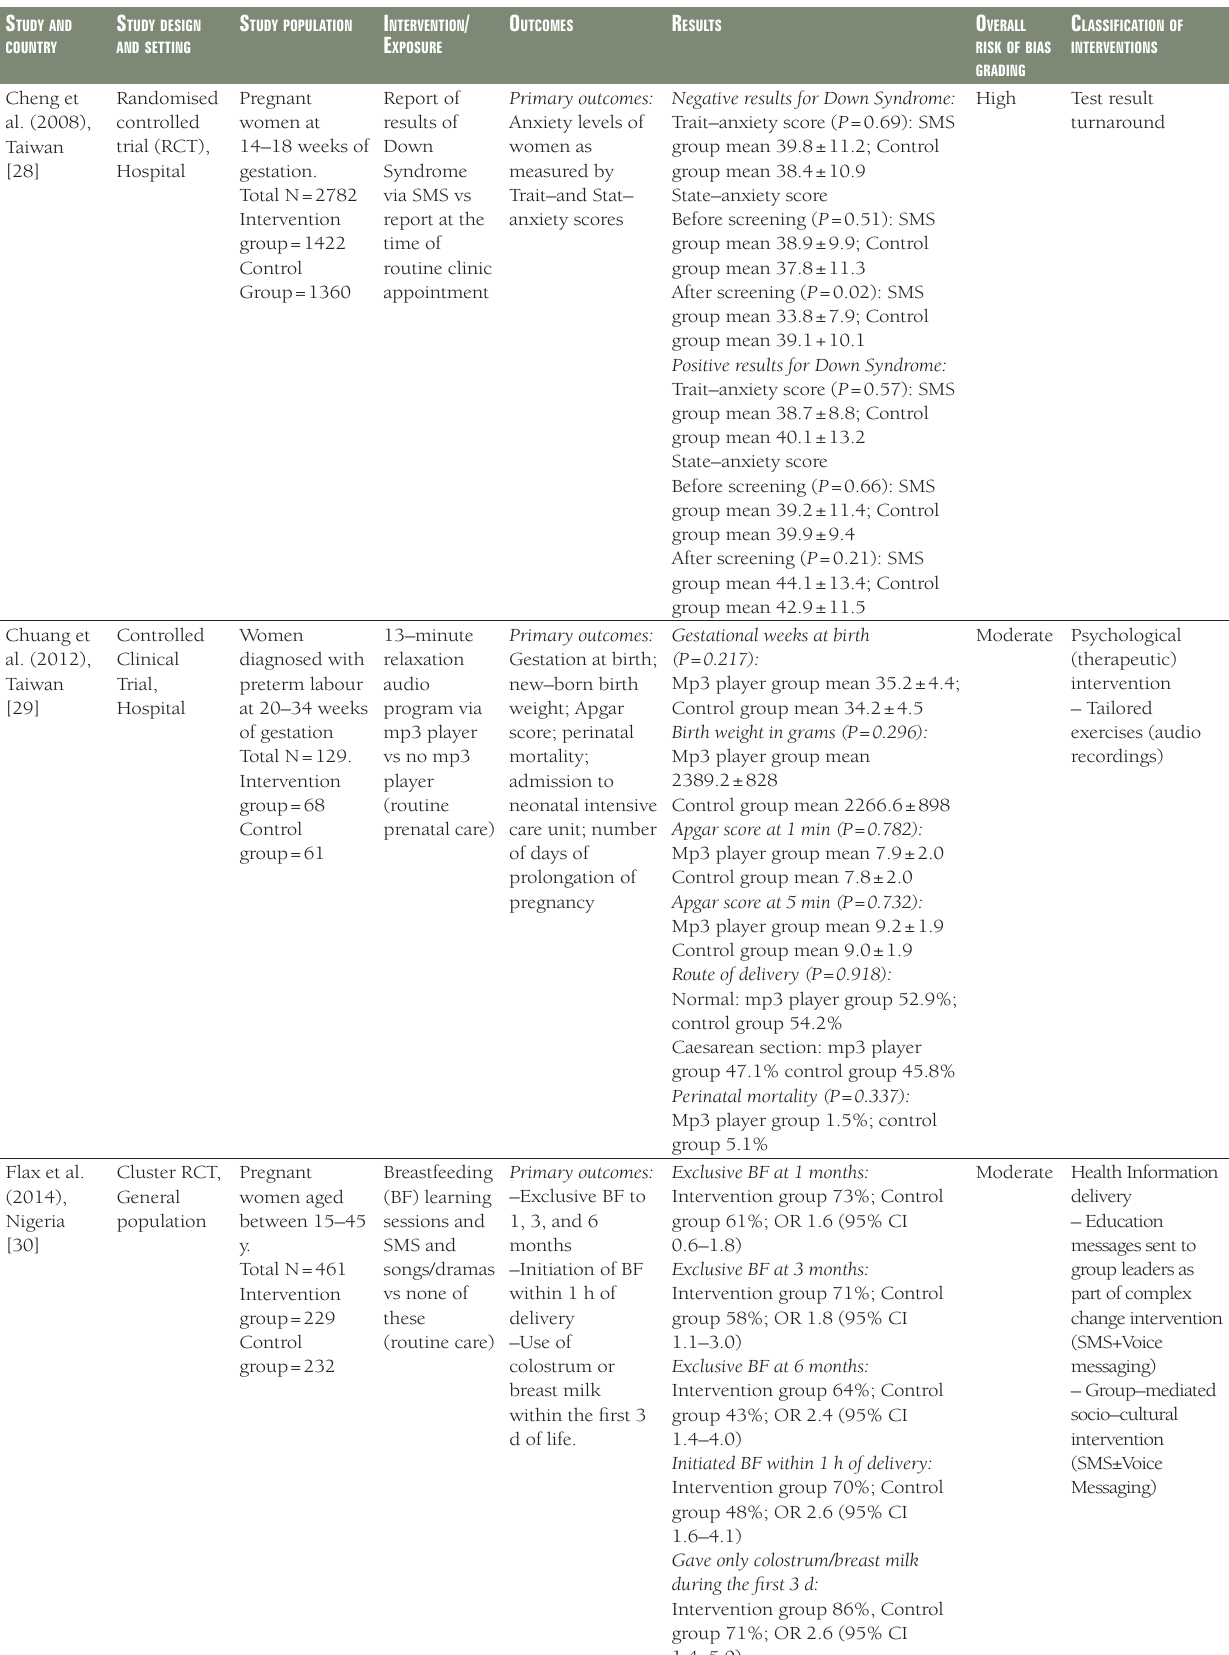
Table 1. Characteristics and results of studies investigating the effectiveness of mHealth interventions for maternal, newborn and child health in low– and middle– income countries during January 1990 – May